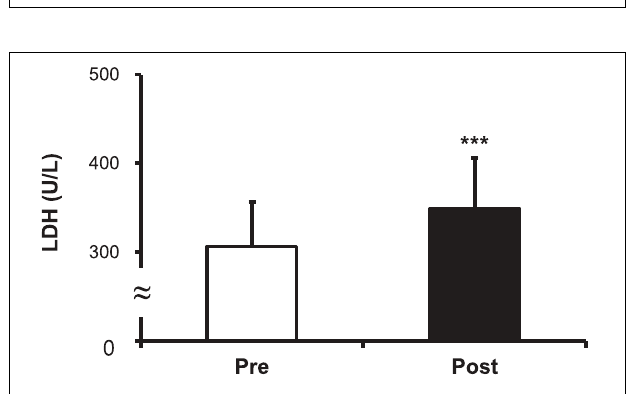
FIGURE 6 | Comparison of serum creatine kinase (CK) concentration before (Pre) and after (Post) hot water bath (42 ± 0.5 ◦ C) immersion. Values are mean ± SD. *** P < 0.001, statistically significant difference between Pre- and Post-exposure values.